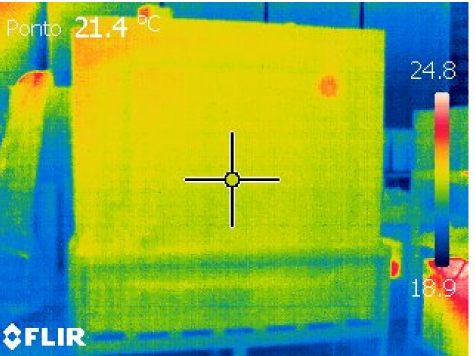
Figure 11. Infrared image from the cold side of hotbox during the test with the reed panel.